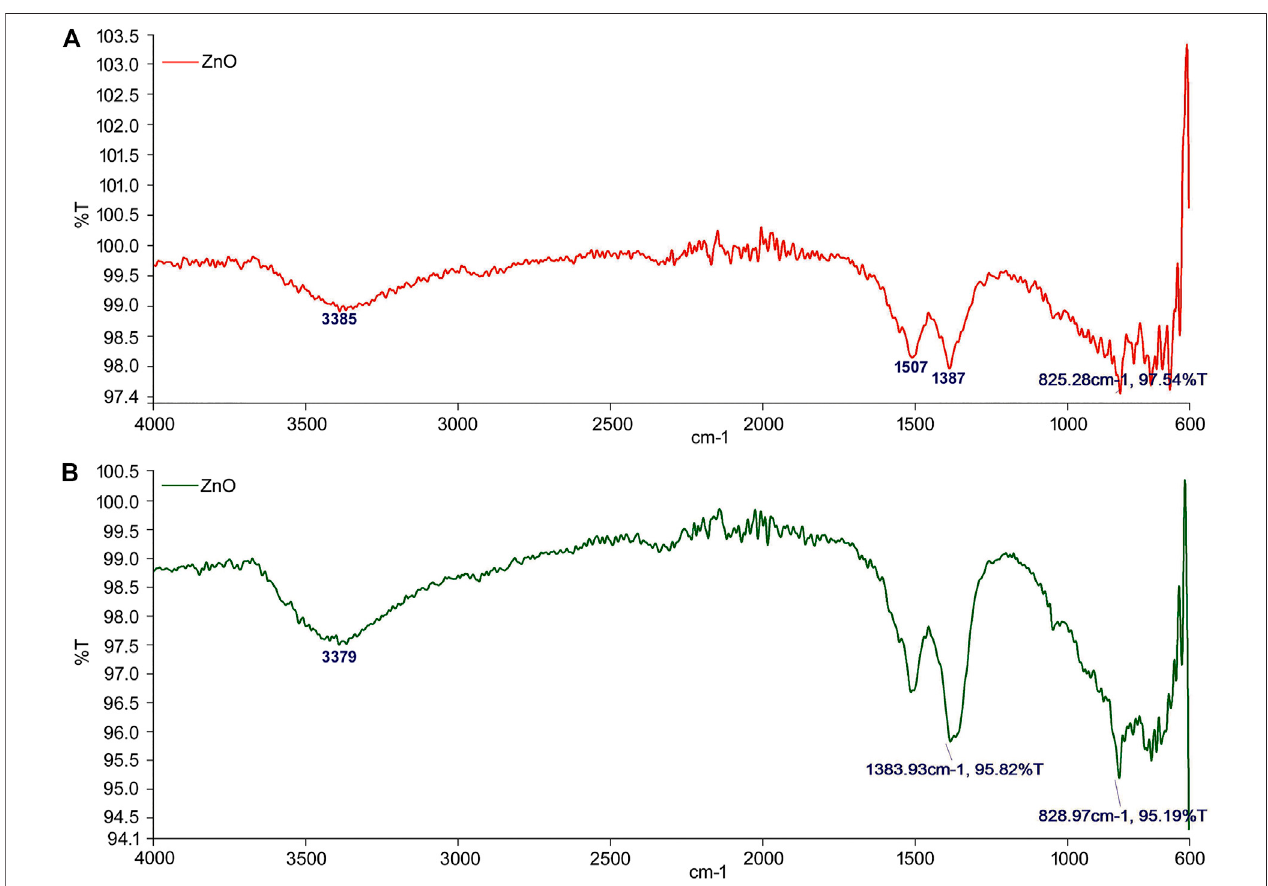
FIGURE3| Fouriertransform infraredspectroscopyanalysisofbiogenicZnO-NPs. (A) Ethanolextractof S.chirayita leavesand (B) methanolextractof S.chirayita leaves.